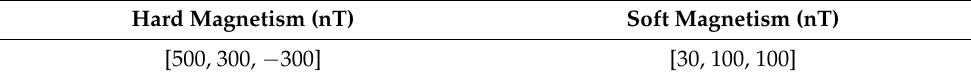
Table 2. Simulation data.